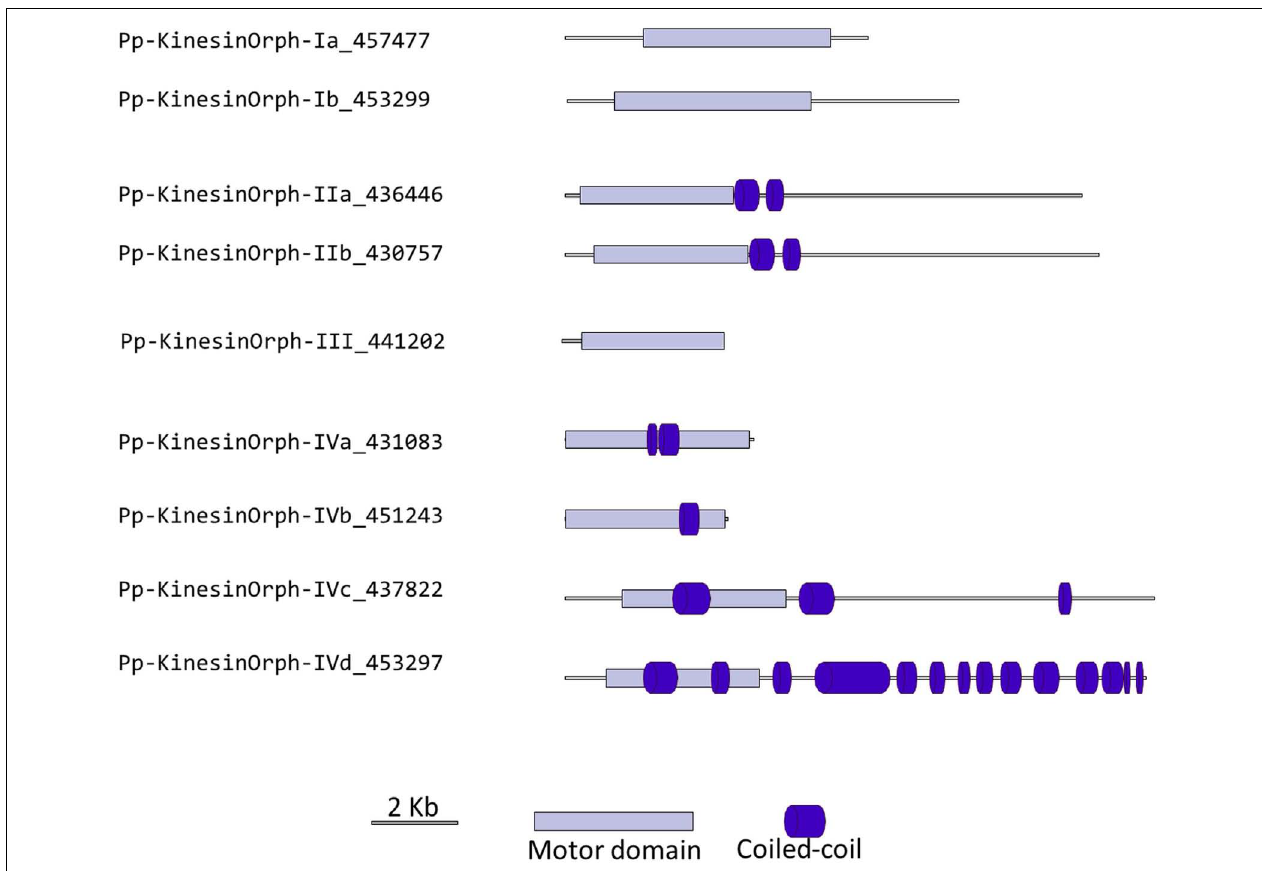
FIGURE 15 | Gene models of orphan kinesins. Schematic diagrams showing the structure and domain architecture of orphan kinesins. Domains are indicated at the bottom of the diagrams.